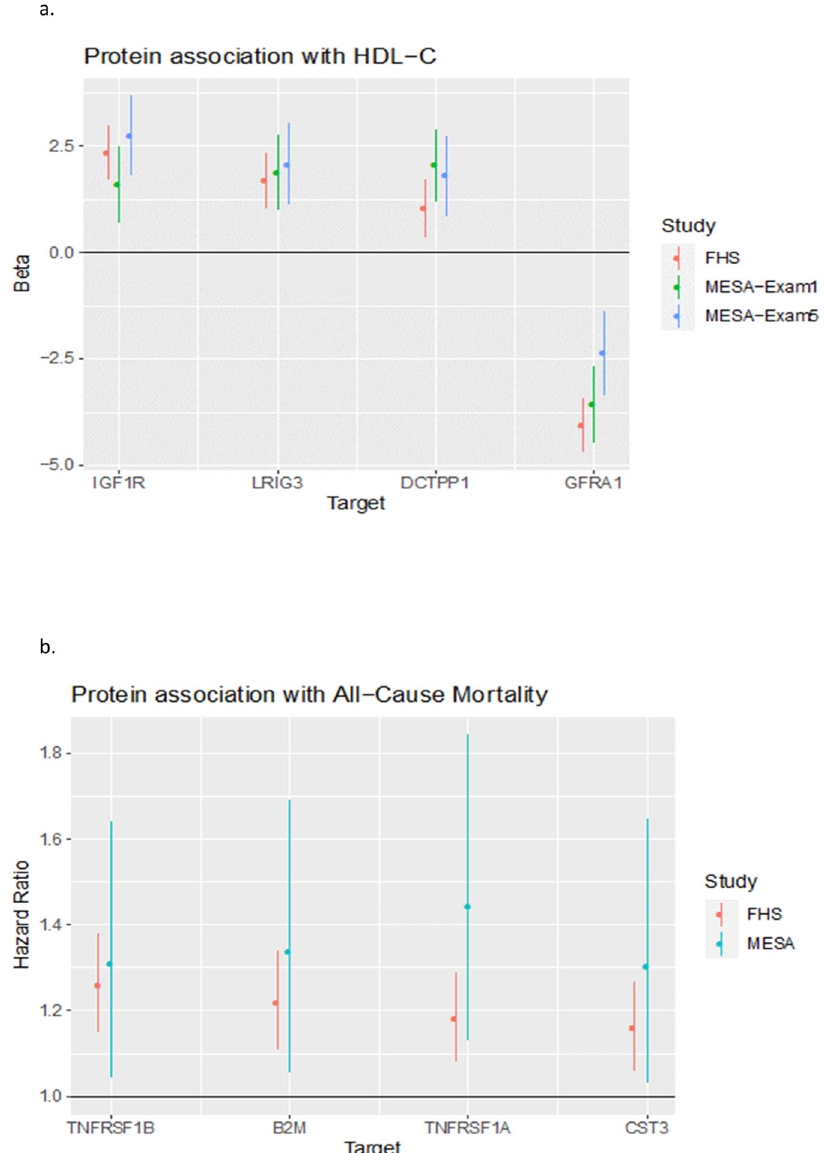
Fig. 3 LAG3 related proteins with (a) HDL-C associations discovered and validated in both MESA and FHS, and (b) all-cause mortality associations discovered in FHS and with nominal support from MESA. Plots show estimated effects and 95% con fi dence limits. Analyses were performed with inverse normal transformed protein levels in MESA and log-transformed protein levels in FHS. a Association of HDL-C with protein levels was examined by linear regression with covariate adjustment for age, sex, study site (in MESA), race/ethnicity (in MESA), PCs of ancestry, BMI, triglycerides, pack-years of smoking (in MESA), current smoking (in FHS), current alcohol use, LAG3 protein level, plate ID and batch (in FHS). Among the 183 proteins examined for association with HDL-C in both MESA and FHS, four of them were discovered and validated in both cohorts (leucine rich repeats and immunoglobulin like domains 3 [LRIG3], DNV family receptor alpha 1 [GFRA1], insulin like growth factor 1 receptor [IGF1R] and DCTP pyrophosphatase 1 [DCTPP1]). b Of the 183 proteins examined for association with CHD and all-cause mortality in MESA, we did not observe any results at FDR < 0.05. In FHS, while there were no associations at FDR < 0.05 for CHD, we observed that 18 of the 183 LAG3-associated proteins demonstrating FDR < 0.05 were signi fi cantly associated with all-cause mortality based on two-sided Z-tests for the coef fi cients from Cox regression with a total sample of n = 1913, including 650 events (Supplementary Data 12). In MESA, none of these 18 proteins reached Bonferroni-corrected statistical signi fi cance, but four of the 18 proteins showed nominal associations with all-cause mortality (tumor necrosis factor receptor super family 1 A [TNFRSF1A], beta-2-microglobulin [B2M], tumor necrosis factor receptor super family 1B [TNFRSF1B] and cystatin C [CST3]; all P < 0.05 based on two-sided Z-tests for the coef fi cients from Cox regression with n = 935 including 95 events. Association of baseline protein levels with all-cause mortality was examined under a Cox proportional hazards model with covariate adjustment for age, sex, race/ethnicity (in MESA), PCs of ancestry, BMI, total cholesterol, HDL-C, SBP, DBP, pack-years of smoking (in MESA), current smoking status (in FHS) and batch (in